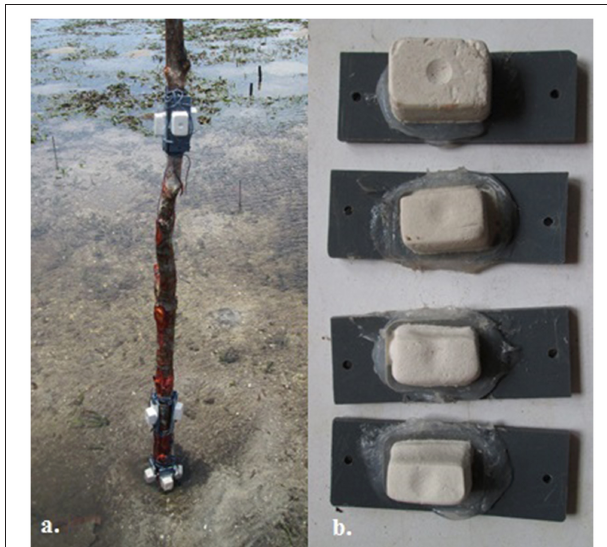
FIGURE 3 | Plaster of Paris clods for the current speed monitoring. (a) Clod cards mounted to a stick in field (b) Clod card drying after removal from the field, showing clear differences in dissolution.